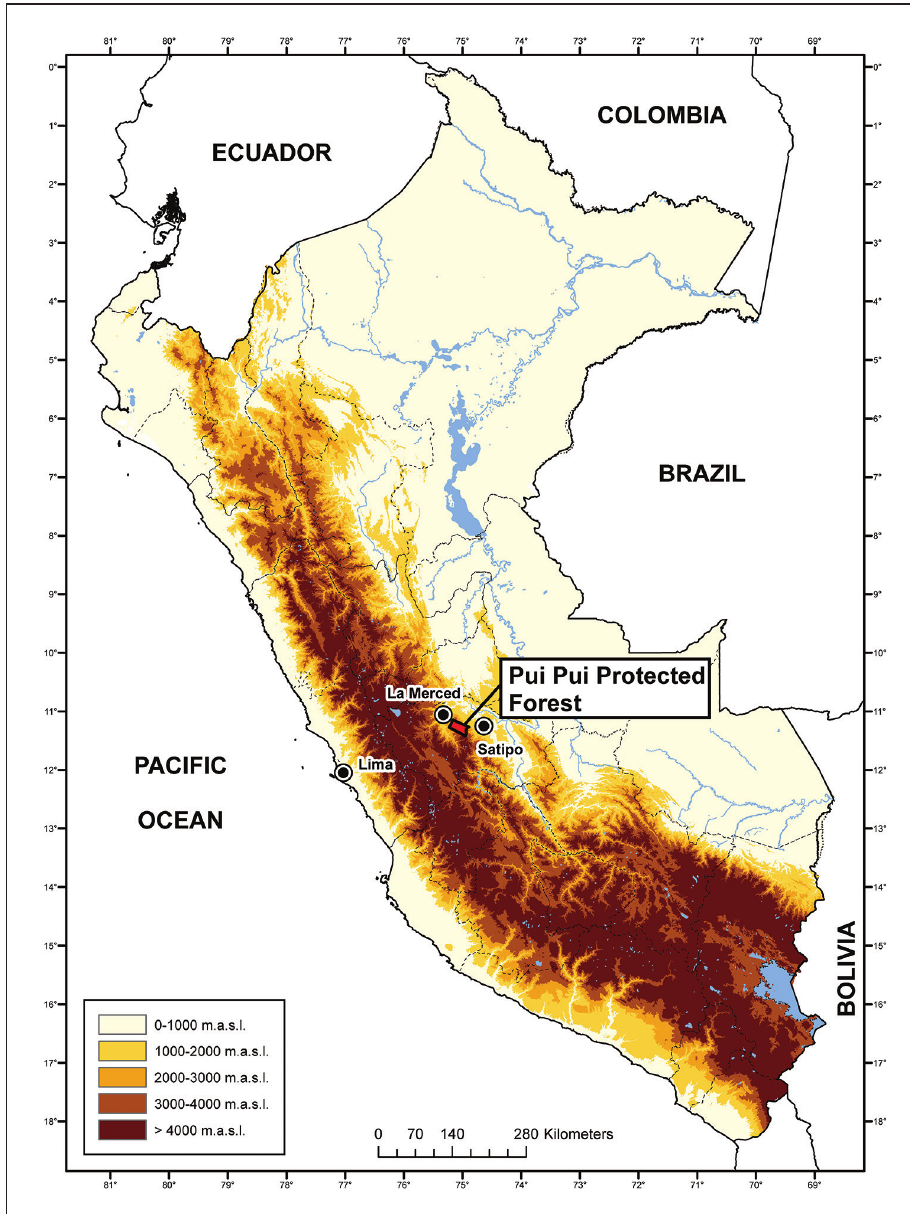
Figure 1. Map of Peru with the Pui Pui Protected Forest indicated in red. of snout), head width (HW, at level of angle of jaw), horizontal eye diameter (ED), interorbital distance (IOD), upper eyelid width (EW), internarial distance (IND), eye–nostril distance (E-N, straight line distance between anterior corner of orbit